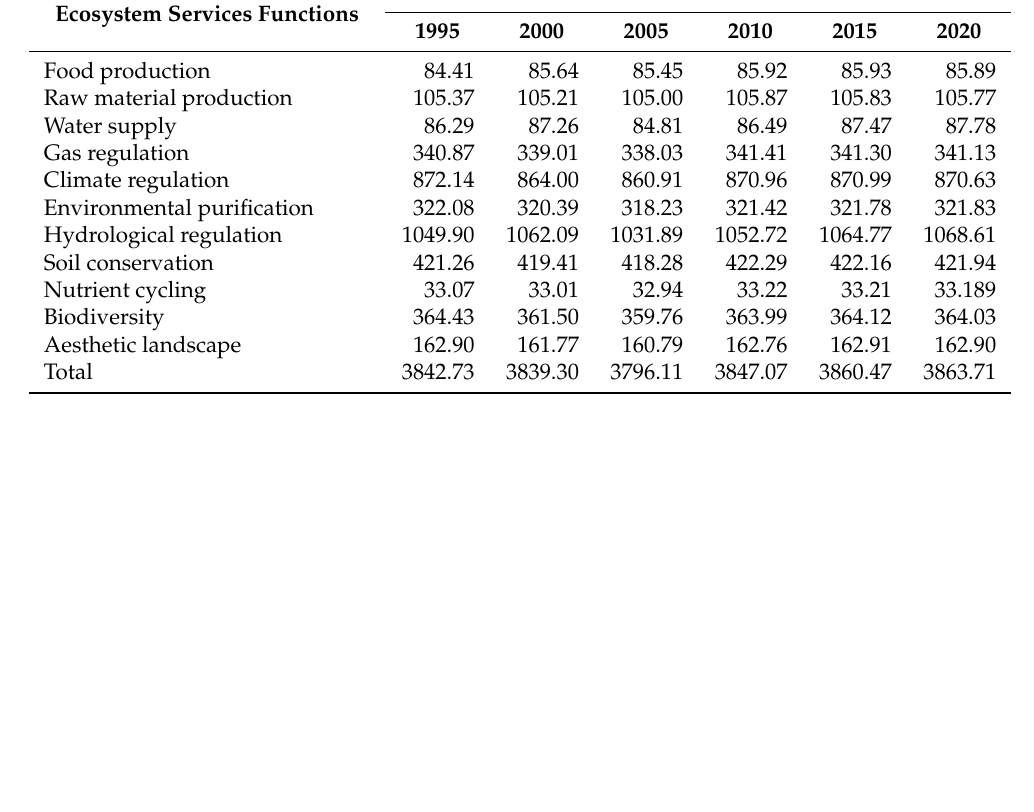
Table 3. ESV of different ecosystem services in Inner Mongolia (10 8 yuan). Ecosystem Services